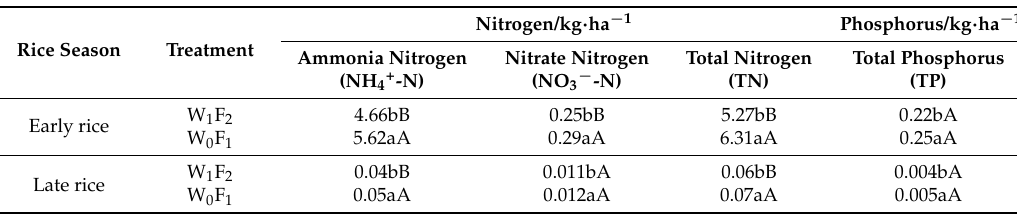
Table 4. Effect of efficient water-fertilizer utilization technique on the discharges of nitrogen and phosphorus in paddy